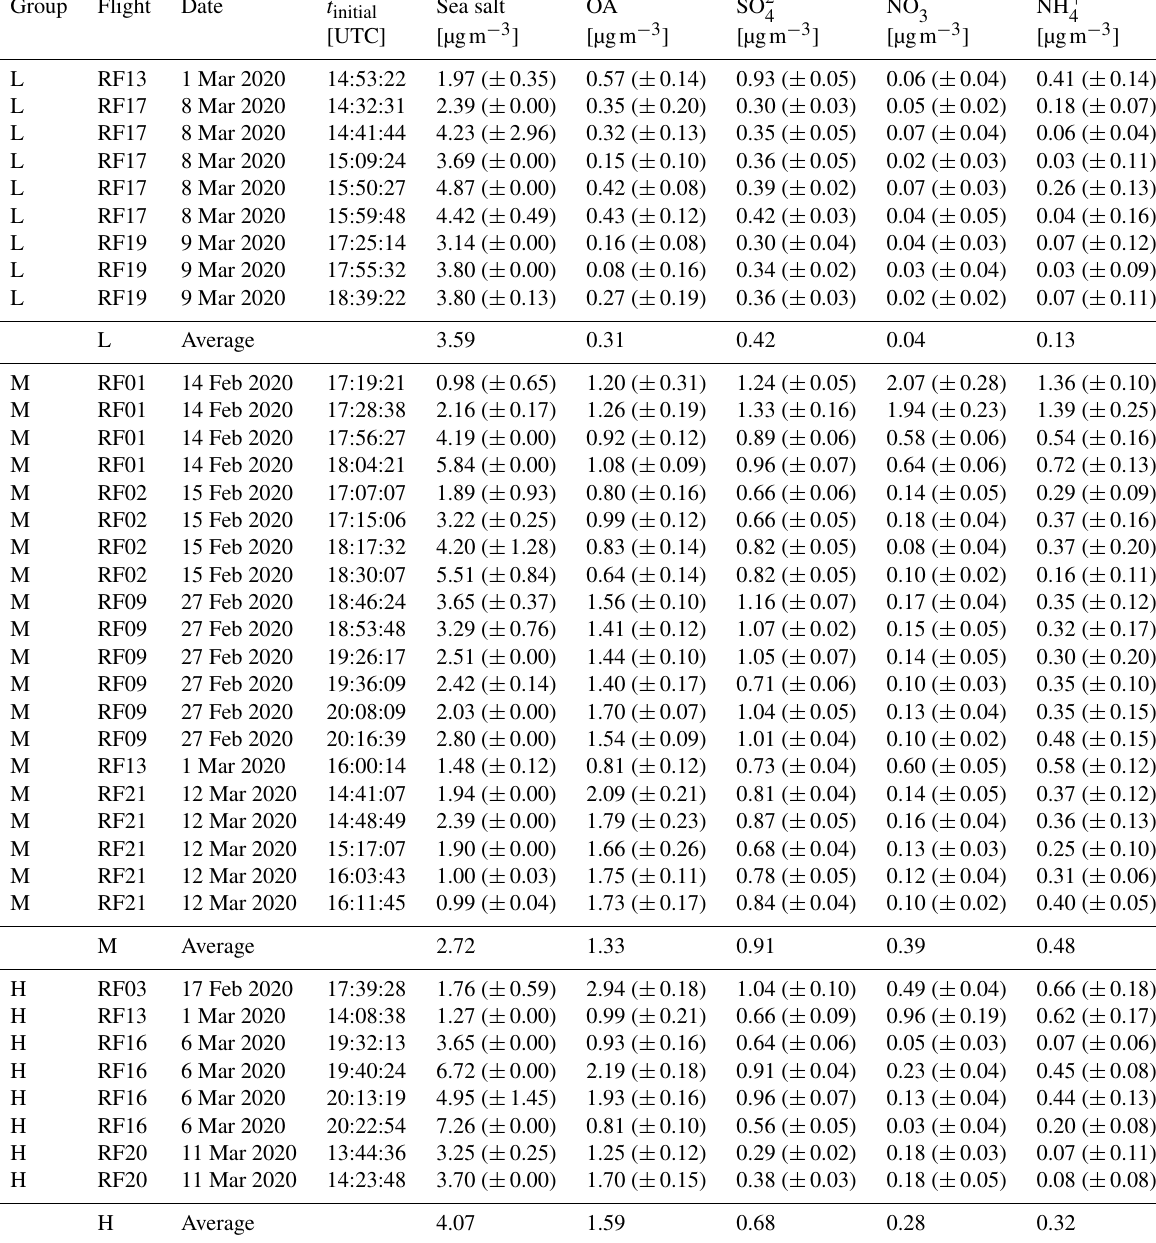
Table 3. All pairs’ aerosol composition below cloud base (BCB) during the February–March 2020 deployment. Mean values and standard deviation in parentheses for organic aerosol (OA), SO 2 − All measurements are given at standard temperature and